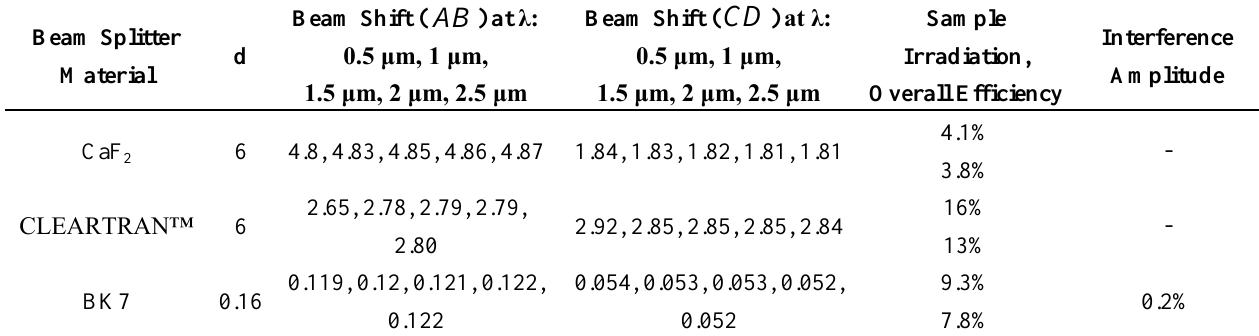
Table 1. First beam splitter performances for various materials as a function of the wavelength λ. All distances are given in mm, while the irradiation and efficiency are given as percentage of the incoming beam, as well as the pk–pk amplitude of the interference effect. Here the values are averaged taking into account the spectral resolution as given in Section